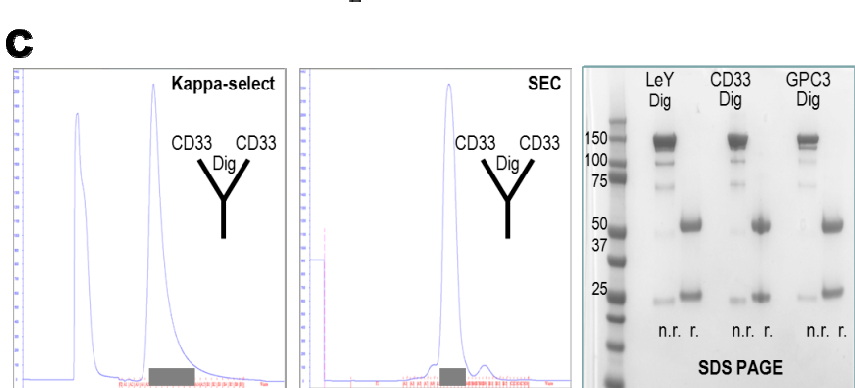
Figure 1. Design and generation of TriFabs. ( a ) TriFabs have the IgG hinge replaced by linker peptides without disulfides, and the CH2 regions by VH or VL. Hetero-dimerization is achieved by disulphide-stabilized knob-into-hole CH3, and by introducing a H44-L100 disulphide in the Fv. Interchain disulfides that connect light and heavy chains and the engineered stem heterodimer are indicated by black bars; ( b ) Fusion sequences linking CH1 with VH or VL with CH3. The N-terminus of Dig-VH and GPC3-VH is QVQL, DVQL for LeY-VH, EVQL for CD33-VH. The N-terminus of Dig-VL is DIQM, GPC3-VL DVVM, LeY-VL DVLM and CD33-VL DIQL. The N-terminal elbow region of CH3 hole is EIKG for GPC3, LeY and Dig, and EVKG for CD33; ( c ) TriFabs are purified from cell culture supernatants by affinity chromatography with kappa-select ( left panel, Protein A does not capture our TriFabs). After loading supernatants to the column (left peak in Figure 1c), TriFabs were eluted with 100 mM Glycine-buffer (pH 2.5), subsequently adjusted to pH 6.0–7.5 with 1 M Tris (pH 9.0). This is followed by size exclusion chromatography ( middle panel). Shaded boxes indicate fractions containing properly folded TriFab. The composition and purity of TriFabs obtained by this simple two-step procedure is shown in the SDS PAGE without (n.r.) and with (r.) sample reduction ( right panel). The purification profiles are exemplarily shown for TriFabs with CD33-CD33-Dig specificity. The purification and profiles of other TriFabs are described in the suppl. data section.